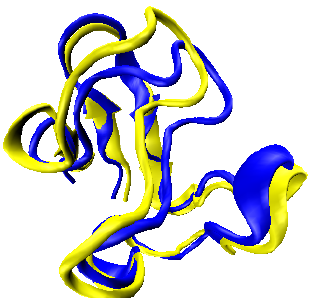
Figure 3. Cartoon representation of the superimposed structures 1BRF (yellow) and 1RWD